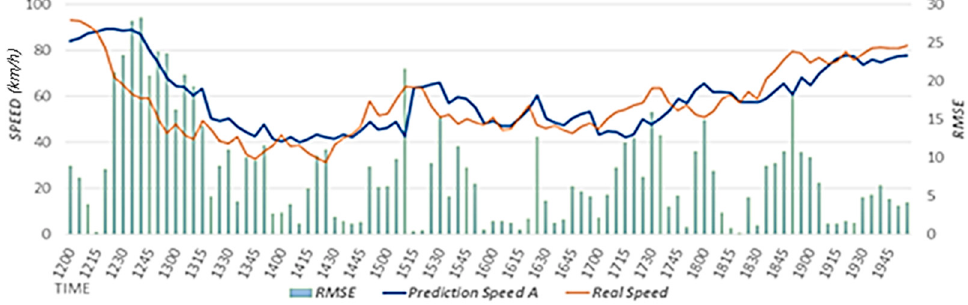
Figure 11. Speed predicted considering the effects of rainfall.